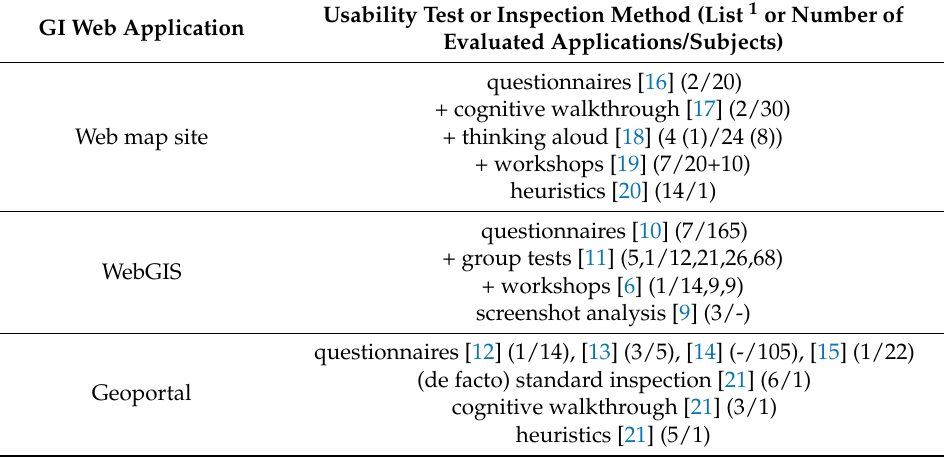
Table 1. Usability studies and applied methods. GIS—geoinformation